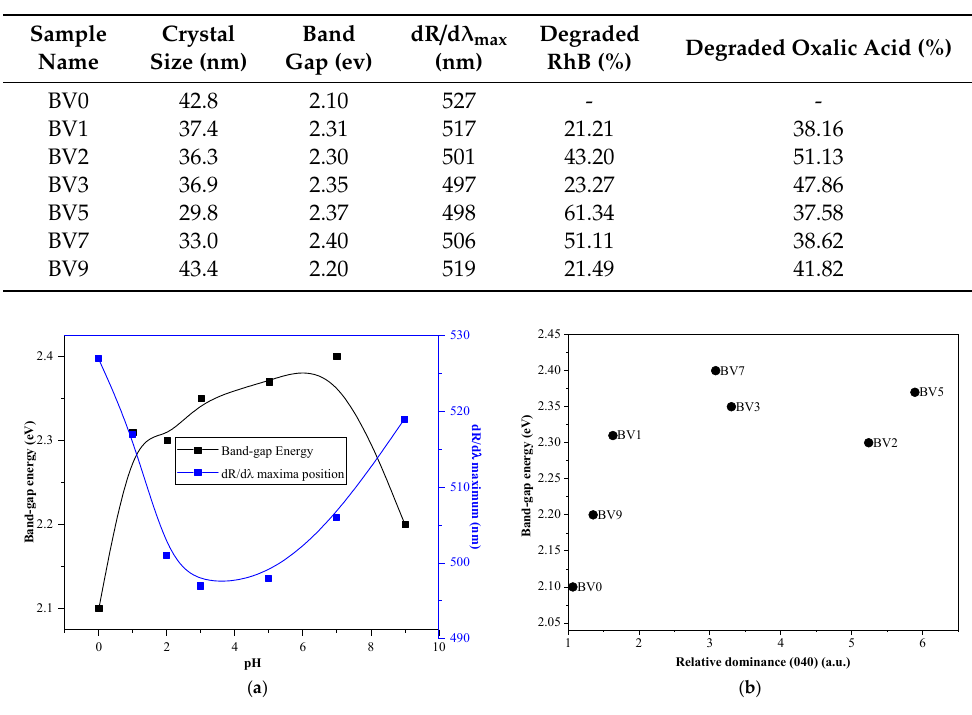
Table 1. The structural, optical and photocatalytic properties of the BiVO 4 crystals.